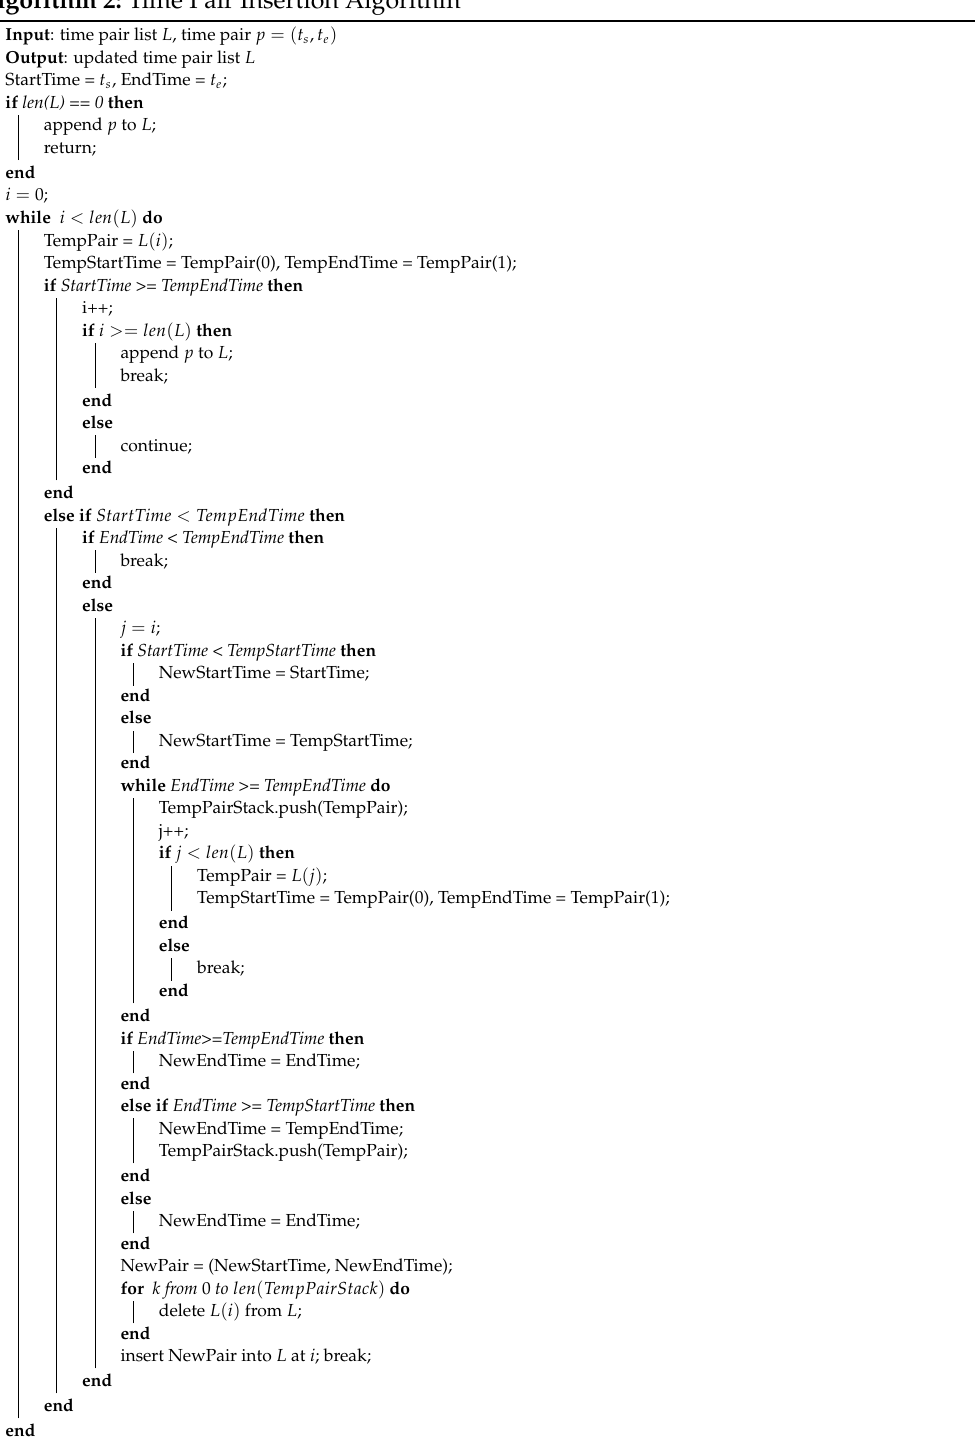
Algorithm 2: Time Pair Insertion